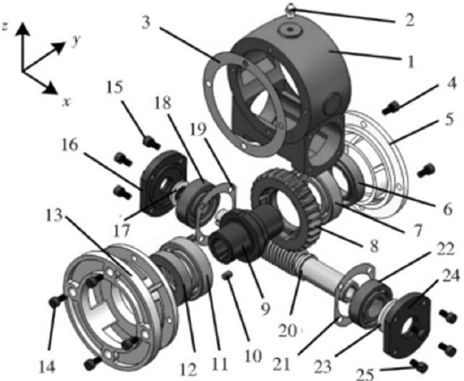
Figure 7. Drawing of worm reducer. Table 1. Parts of worm reducer.